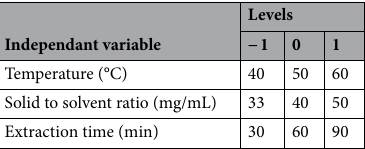
Table 1. Coded levels and actual values of the independent